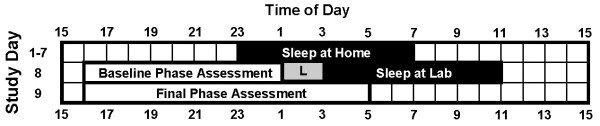
Protocol diagram. This protocol is for a subject sleeping from 23:00–7:00 at baseline (days 1–7). Shaded rectangle with L inside shows time of bright light exposure (2 h, ~4000 lux).